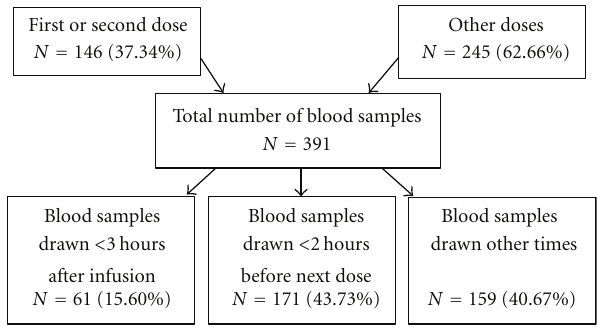
Figure 1: Number of vancomycin serum concentrations regarding to blood sampling time in modeling